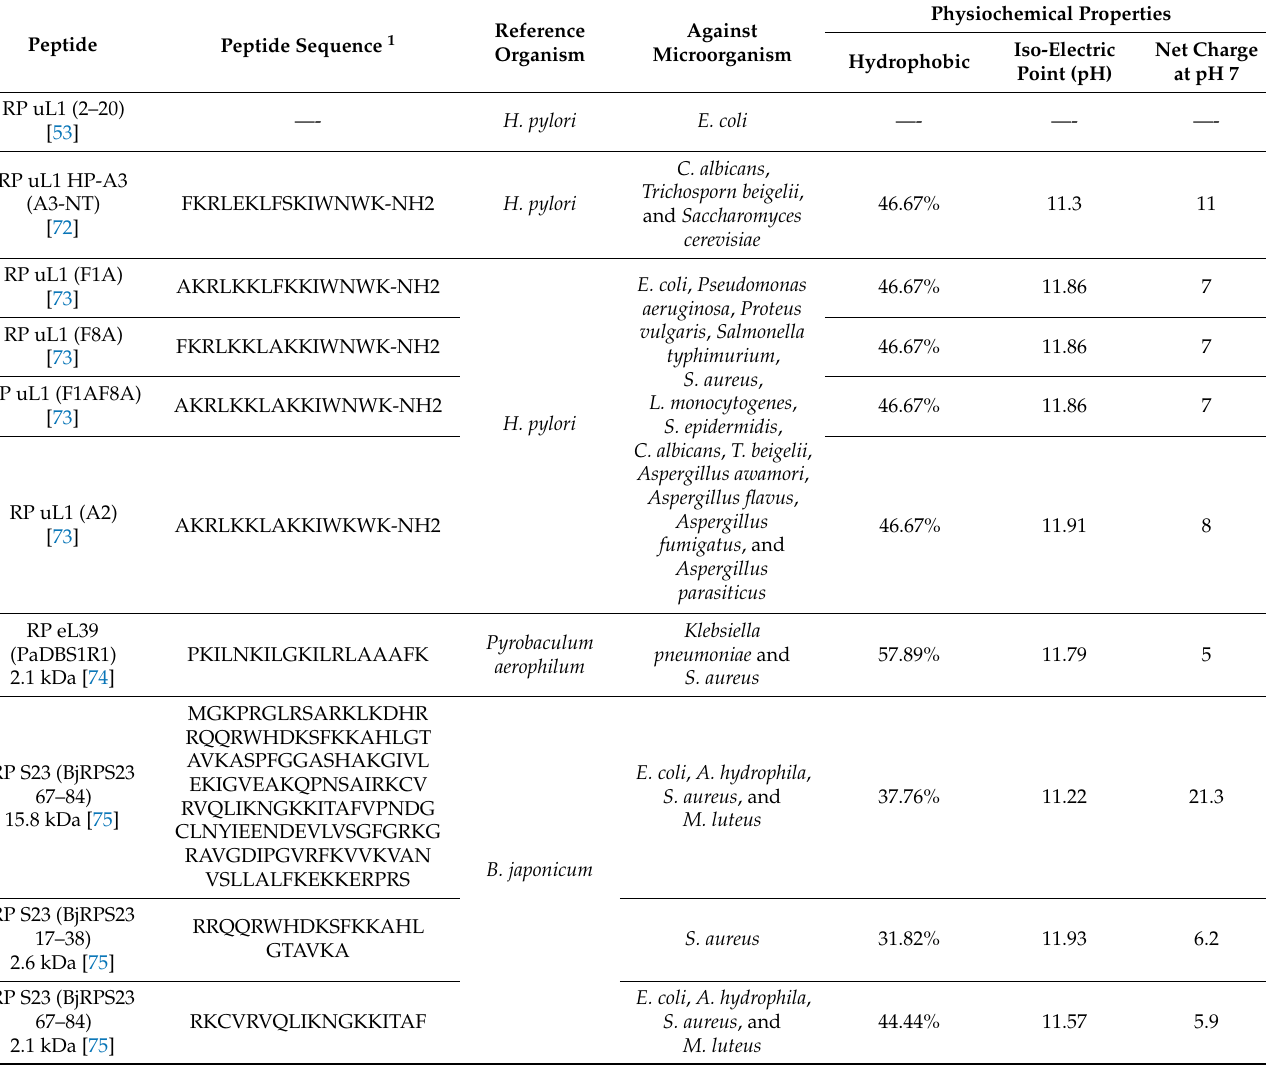
Table 5. Different peptides with antimicrobial activity synthesized from ribosomal